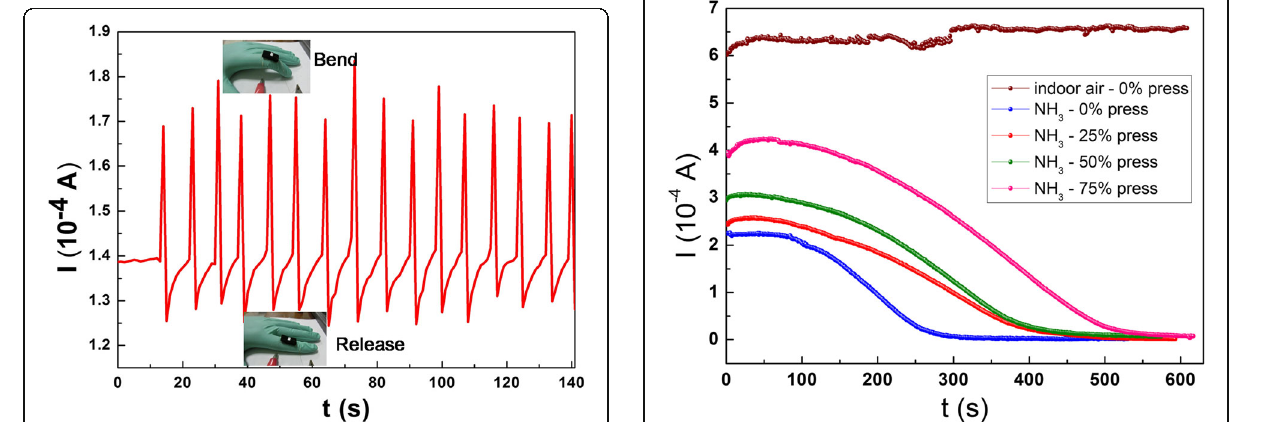
Fig. 10 Current responses of finger bending-release motion detection at a fixed bias of 5 V